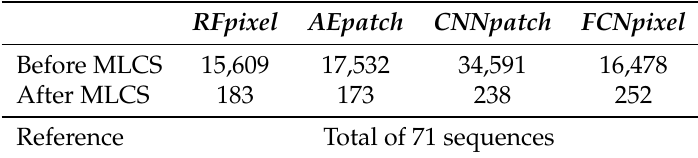
Table 5. Total of output sequences before and after MLCS